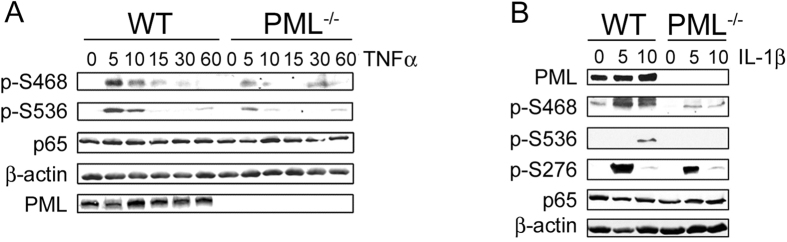
Reduced NF-κB phosphorylation in PML−/− cells.WT and PML−/− MEFs were stimulated with (A) TNFα (10 ng/ml) or (B) IL1β (10 ng/ml) for the indicated time (minutes) and analysed by immuno-blotting with the indicated antibodies.